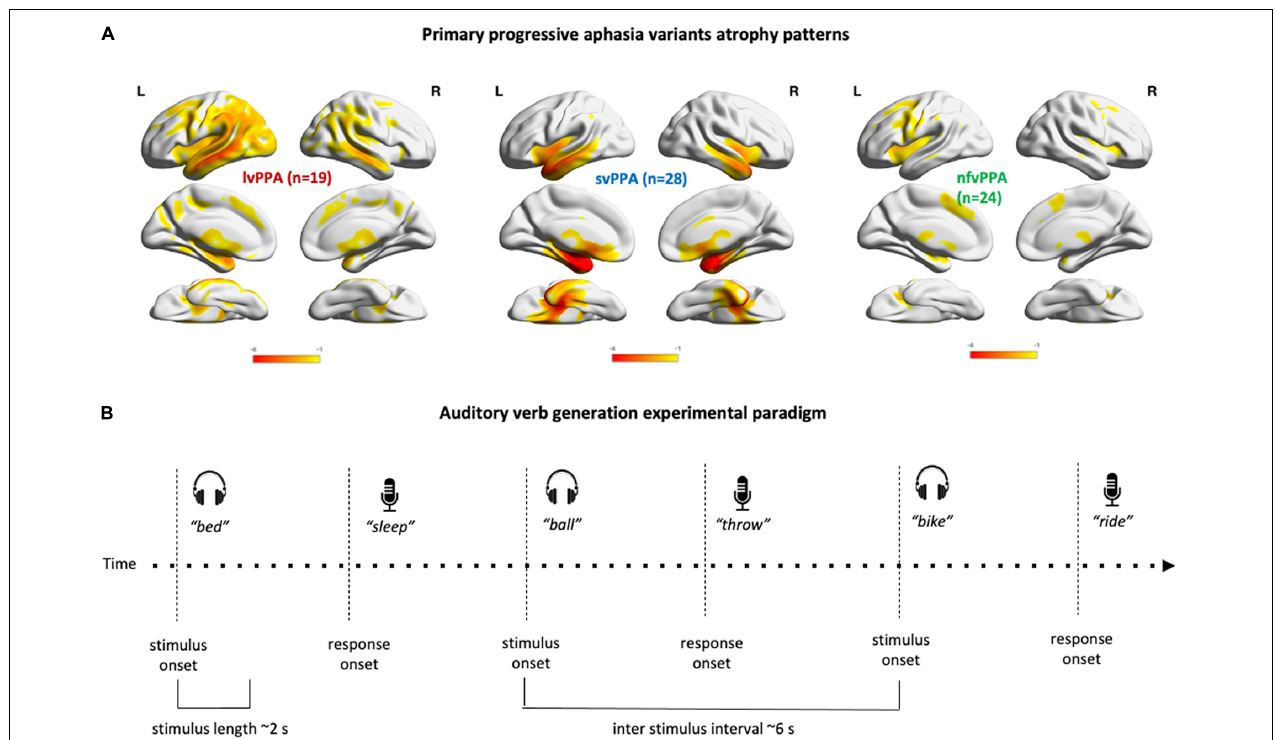
FIGURE 1 | PPA variants atrophy patterns and experimental paradigm. (A) Render illustrating the results of the voxel-based morphometry analysis identifying regions of gray matter volume loss in the three PPA variants relative to healthy controls. (B) Schematic representation of the experimental auditory verb generation task. After each stimulus presentation, a 4 s interval preceded the next stimulus